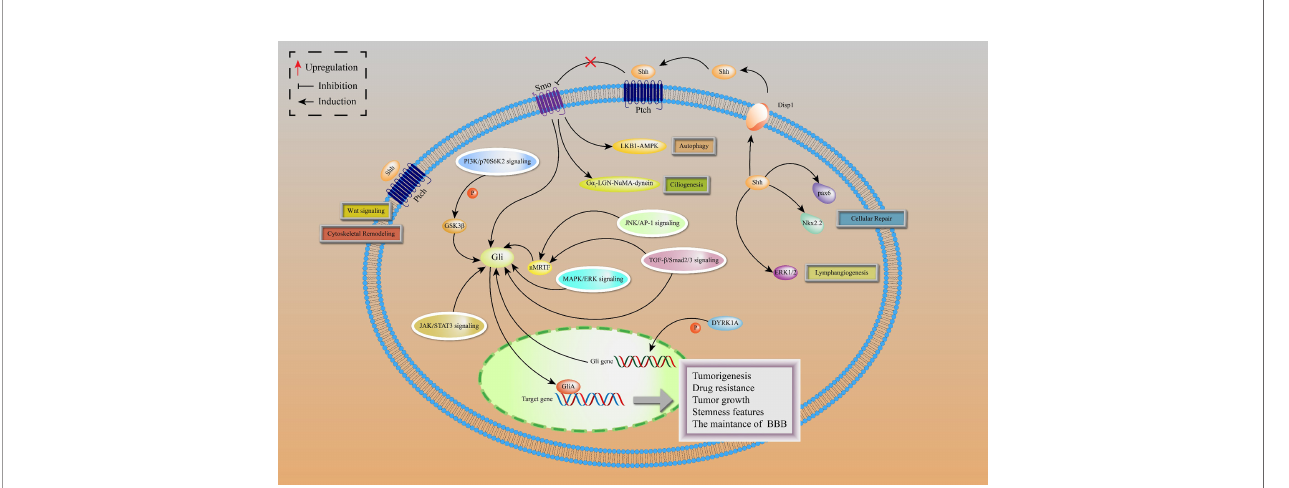
FIGURE 2 | Noncanonical HH signaling transductions are depicted, including SHH-mediated, Ptch-mediated, Smo-mediated and Gli-mediated noncanonical signaling. SHH-mediated noncanonical pathway is associated with cellular repair and lymphangiogenesis. Ptch-mediated but Smo-independent pathway is activated by SHH to induce Wnt signaling and cytoskeletal remodeling. In Smo-mediated but Gli-independent noncanonical pathway, the SHH ligand activates LKB1-AMPK and G a i-LGN-NuMA-dynein axes in neurons, leading to activation of autophagy and ciliogenesis. There is a crosstalk between Gli activated and Smo-independent pathways as well as with numerous oncogenic pathways, resulting in lung cancer tumorigenesis and development.